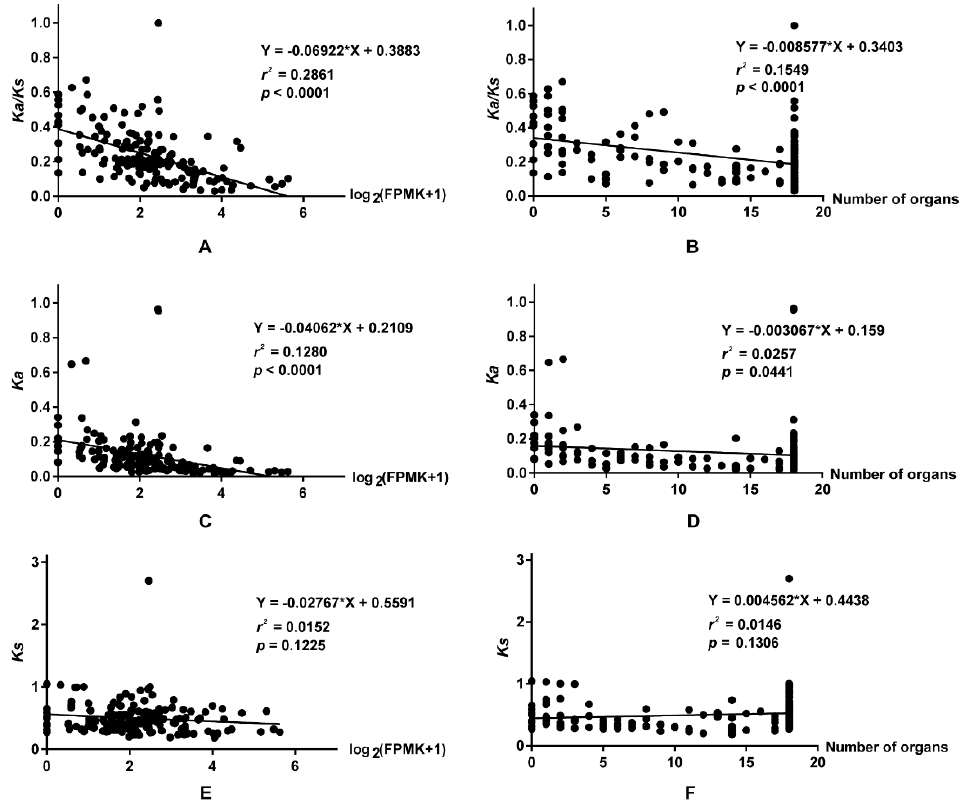
Figure 8. Correlation analyses between Ka/Ks , Ka , and Ks with average expression levels and expression breadth in B. napus . The average expression levels were calculated using the sum of the expression levels in organs divided by the numbers of organs. Here, the organs were defined as the organs with expression levels higher than 0.5. ( A , C , E ) represent the correlation between Ka/Ks , Ka , and Ks with expression levels, while ( B , D , F ) represent the correlation between Ka/Ks , Ka , and Ks with expression breadth, respectively. The expression data were normalized with Log 2 (FPKM + 1). FPKM: fragments per kilobase of exon model per million reads mapped.